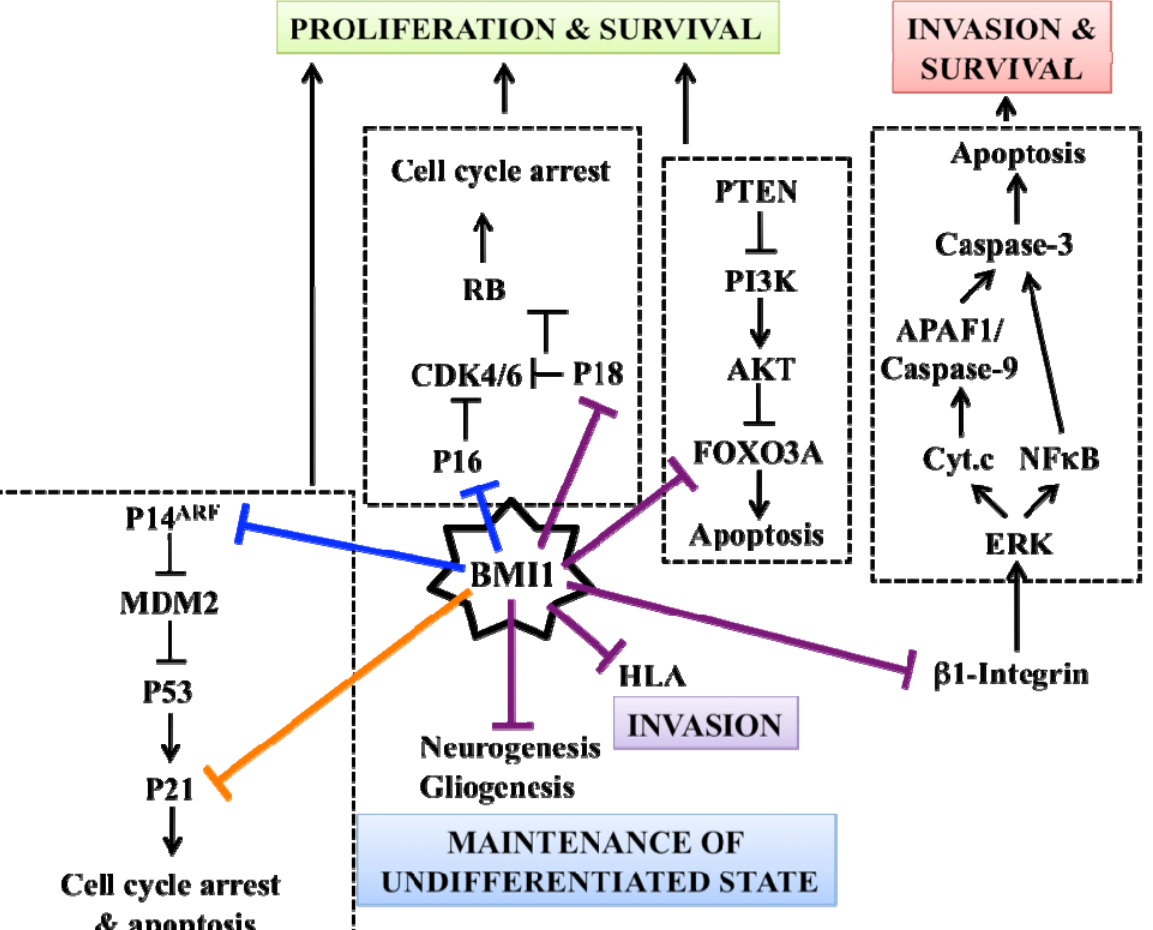
Figure 2. Oncogenic functions of BMI1 in Glioblastoma multiforme (GBM). BMI1 regulates multiple molecular pathways in order to maintain GBM cancer stem cells (CSCs) self-renewal capacity and promote tumor invasion. Previously identified BMI1 target genes are delineated by blue bars. Confirmed (orange bar) and potentially new target genes (purple bars) are also shown. Based on work from